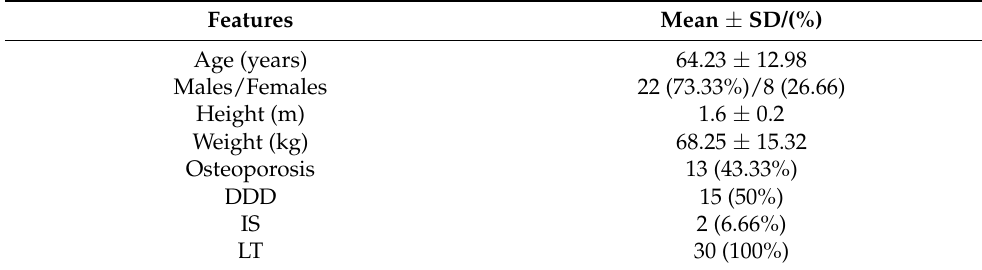
Table 1. Main features of the 30 study transplant patients. Features